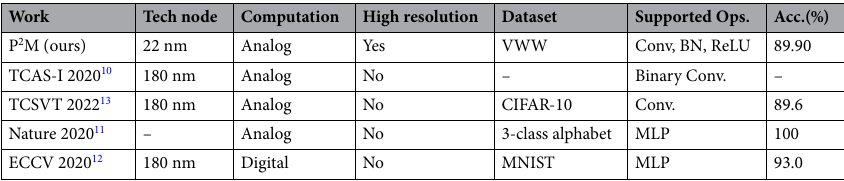
Table 4. Comparison of P 2 M with related in-sensor and near-sensor computing works.